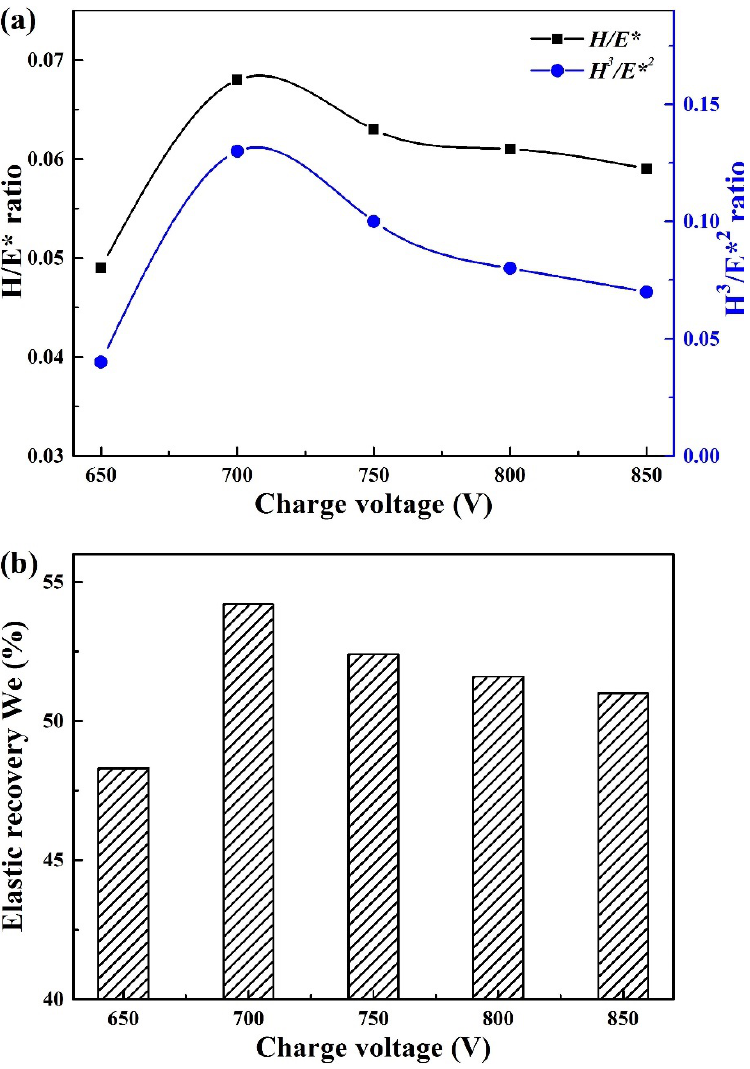
Figure 8. H/E* and H 3 /E* 2 ratio ( a ), elastic recovery W e ( b ) of Mo–Cu–V–N coatings at various charge voltages.